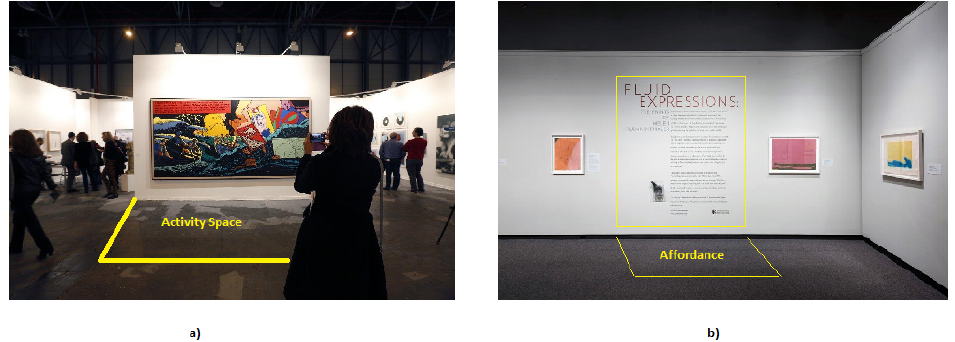
Figure 5. ( a ) Activity space and ( b ) affordance space.